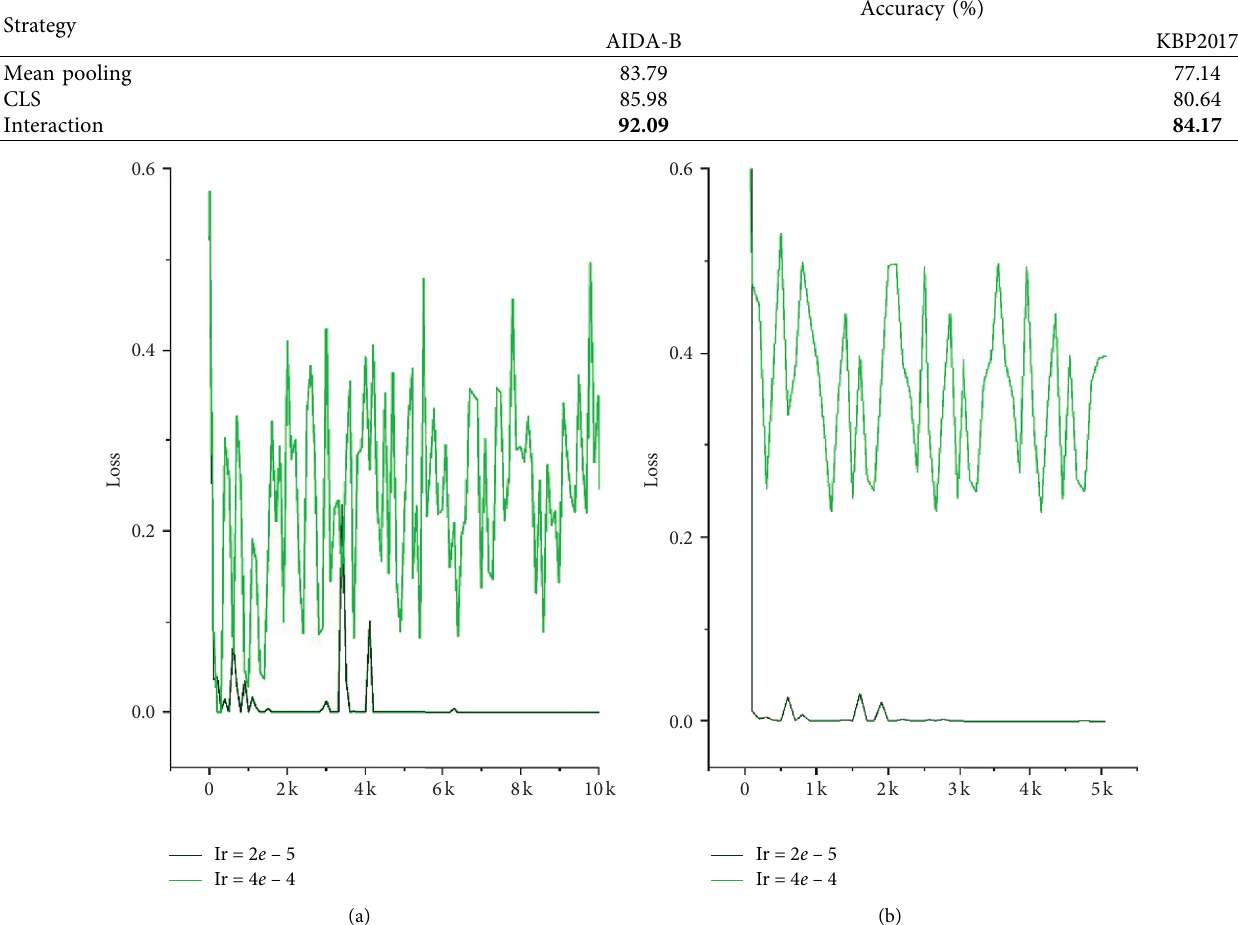
Figure 5: Test loss of ELSR using two different datasets. (a) Size of AIDA-B. (b) Size of